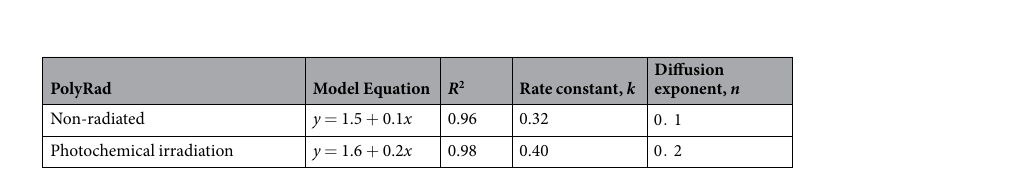
Table 3. Kinetic modeling of melatonin release from PolyRad nanoparticles.